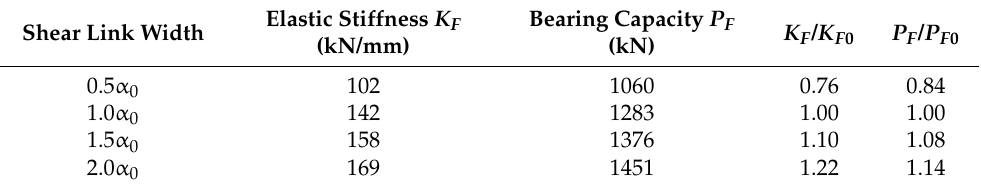
Figure 24. Load–displacement curves for different t w,s values. Figure 24. Load – displacement curves for different t w,s values. Table 7. Comparison of mechanical properties for different t w, s Table 7. Comparison of mechanical properties for different t w, s values.